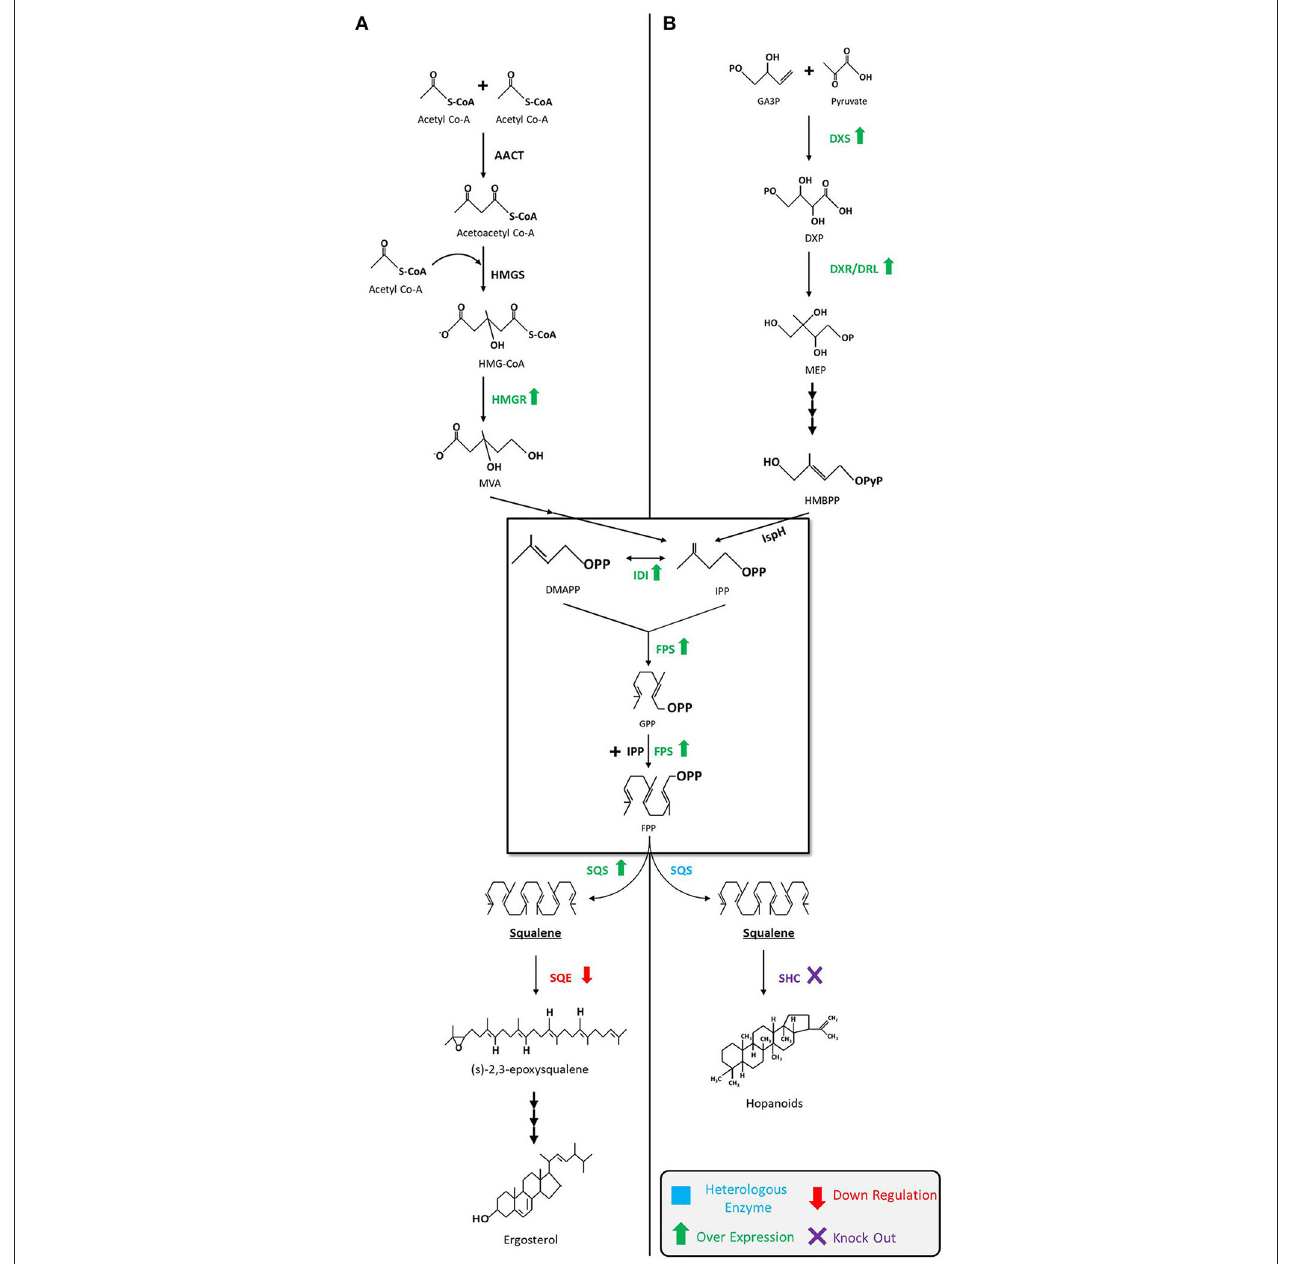
FIGURE 2 | Squalene biosynthetic pathways and production strategies. (A) Squalene biosynthesis via MVA pathway in yeast, fungi, and algae. The engineering strategies for enhanced squalene production are as follows: overexpression of HMGR (Polakowski et al., 1998; Tokuhiro et al., 2009; Mantzouridou and Tsimidou, 2010; Dai et al., 2012, 2014; Zhuang and Chappell, 2015; Rasool et al., 2016a,b; Kwak et al., 2017; Paramasivan and Mutturi, 2017; Han et al., 2018; Huang et al., 2018; Wei et al., 2018) and SQS (Dai et al., 2014; Zhuang and Chappell, 2015; Rasool et al., 2016a,b), downregulation of SQE (Garaiová et al., 2014; Hull et al., 2014; Zhuang and Chappell, 2015; Rasool et al., 2016a,b; Han et al., 2018) in yeast; downregulation of SQE in algae (Kajikawa et al., 2015). (B) Squalene biosynthesis via MEP pathway in bacteria. The engineering strategies for the enhanced squalene production are as follows: overexpression of DXS (Ghimire et al., 2009), IDI (Ghimire et al., 2009; Katabami et al., 2015) and FPS (Katabami et al., 2015), introduction of heterologous squalene producing enzyme(s) (Ghimire et al., 2009; Furubayashi et al., 2014a; Katabami et al., 2015; Pan et al., 2015 ) in E. coli ; overexpression of DXS and IDI, and the introduction of FPS into Synechococcus elongatus (Choi et al., 2016); deletion of SHC in Synechocystis (Englund et al., 2014) and Rhodopseudomonas palustris (Xu et al., 2016). MVA, mevalonate; MEP, 2- C -methyl-d-erythritol 4-phosphate; AACT, acetoacetyl-CoA thiolase; HMGS, 3-hydroxy-3-methylglutaryl-CoA synthase; HMGR, HMG-CoA reductase; DMAPP, dimethylallyl diphosphate; IDI, isopentenyl diphosphate isomerase; IPP, isopentenyl pyrophosphate; FPS, farnesyl pyrophosphate synthase; GPP, geranyl diphosphate; FPP, farnesyl pyrophosphate; SQS, squalene synthase; SQE, squalene epoxidase; GA3P,glyceraldehyde-3-phosphate; DXP, 1-deoxy-D-xylulose-5-phosphate; DXS, DXP synthase; DXR, DXP reductoisomerase; DLR, DXR-like enzyme; HMBPP, 4-hydroxy-3-methyl-but-2-enylpyrophosphate; IspH,IPP/DMAPP synthase; SHC, squalene hopene cyclase.